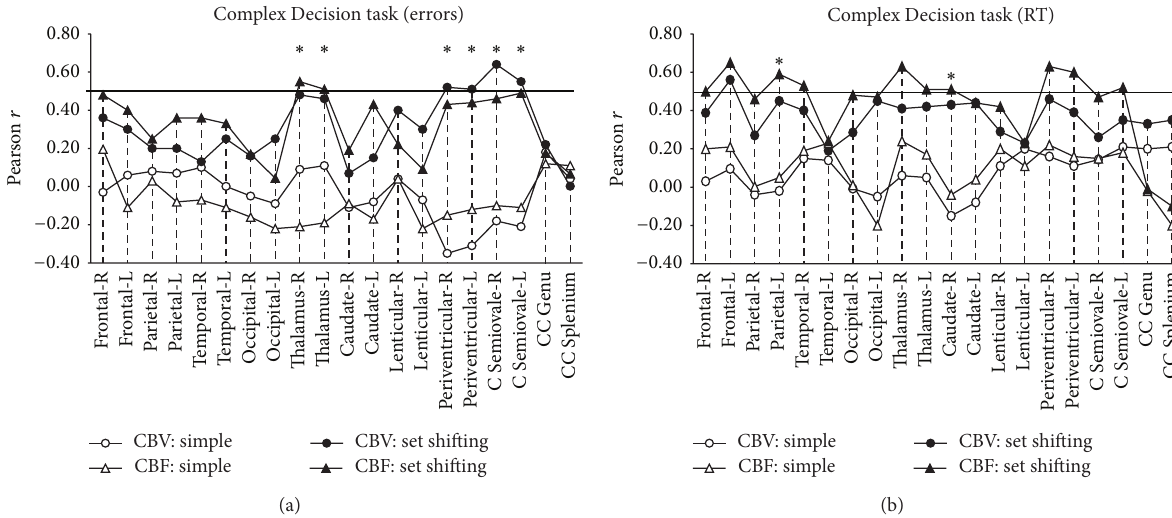
Figure 2: Correlation between performance accuracy and RT during the Complex Decision task and CBF/CBV values for CIS patients. Zero- order Pearson correlation coefficients between performance accuracy (a) and RT (b) during the Complex Decision task and CBF/CBV in 20 ROIs in the left (L) and right (R) hemispheres and the corpus callosum. Coefficients > 0.50 were significant at a Bonferroni-corrected alpha level of .0025 (indicated by horizontal solid lines). Asterisks indicate significant correlations which were also found to be condition specific (based on Fisher’s 𝑧 test for the difference between correlation coefficients in the “simple” and “executive”